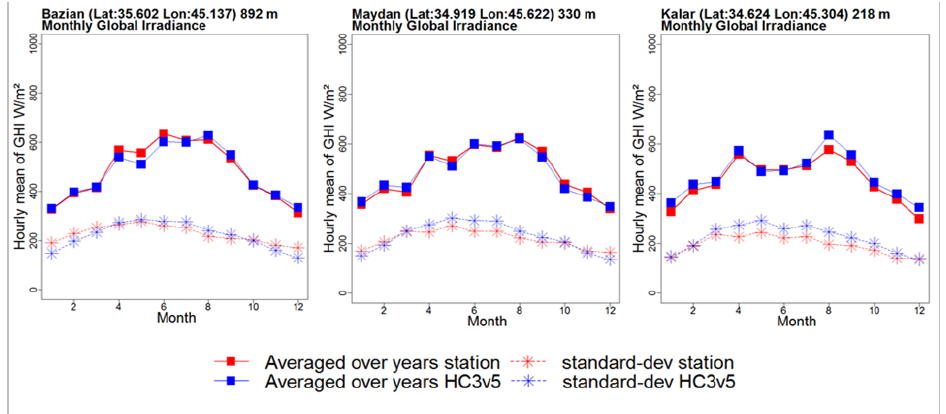
Figure 5. Monthly mean and standard deviation of hourly GHI data in each month aggregated over the data availability for each station with HC3v5. The difference between dots reveals the errors in a month and vice versa. If the dot of the SDD in a month is above the dot of the ground data, it denotes overestimation; otherwise, it denotes underestimation.